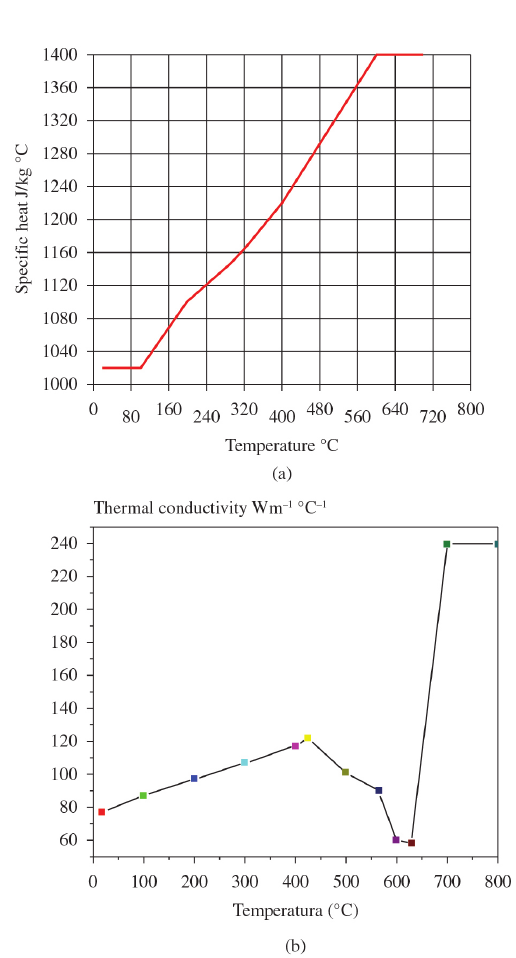
Figure 1. Curves of material properties with different temperatures for AZ31 Mg alloy, (a) specific heat and (b) thermal